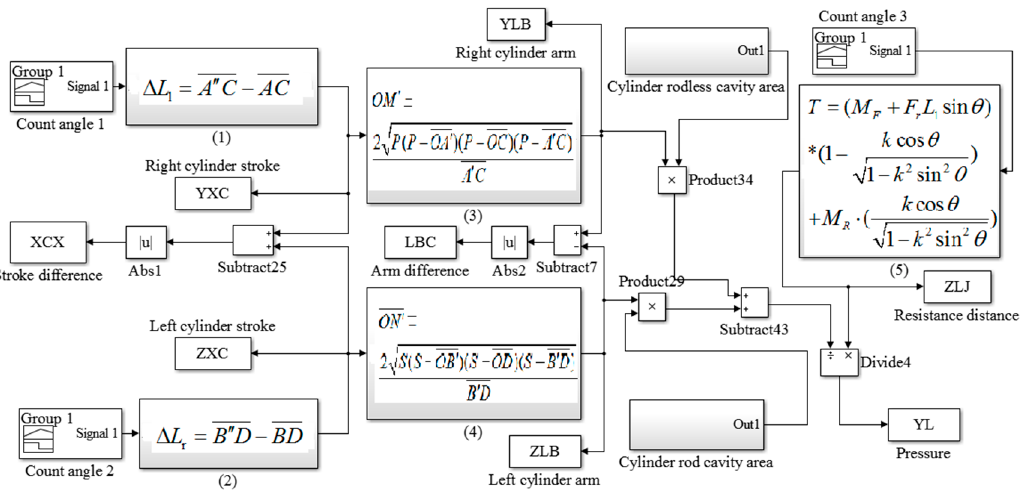
Figure 3. Model of the steering mechanism.